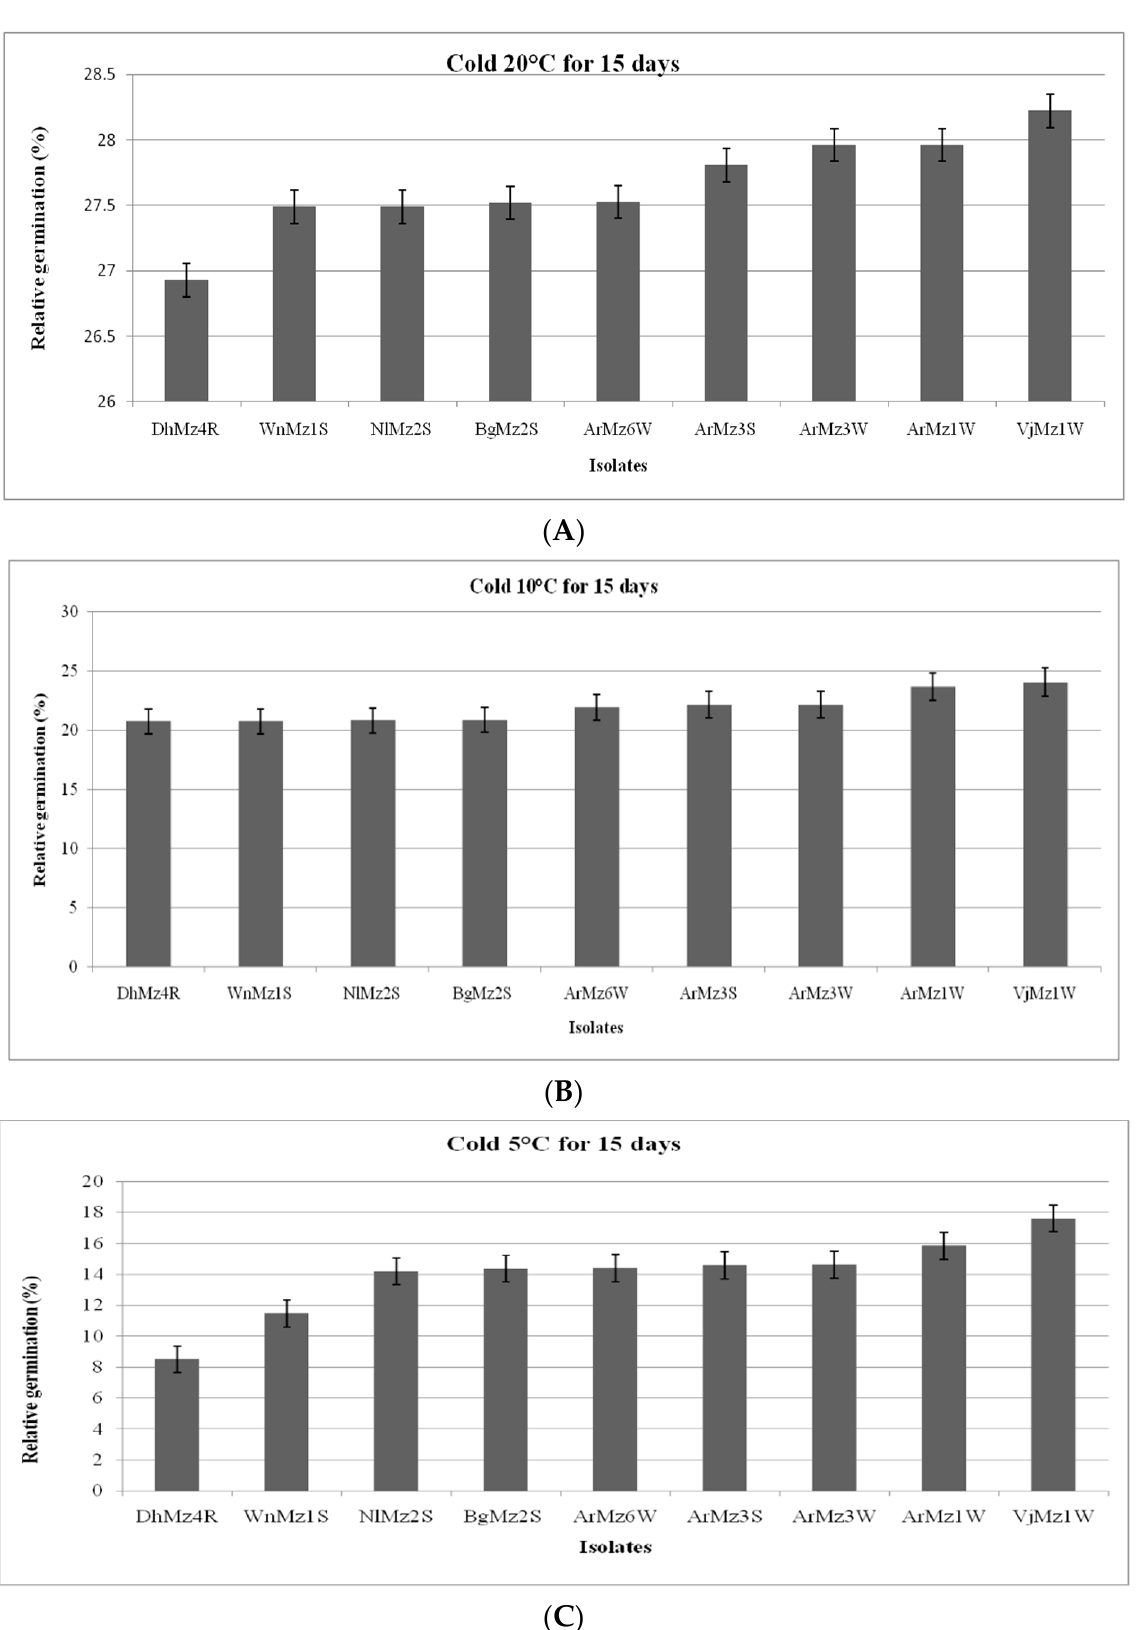
Figure 5. ( A – C ): Relative germination (RG) of Metarhizium spp. conidia after incubation at 5 °C, 10 °C, and 20 °C for 15 days. ( A ) At 20 °C; ( B ) At 10 °C; ( C ) At 5 °C.